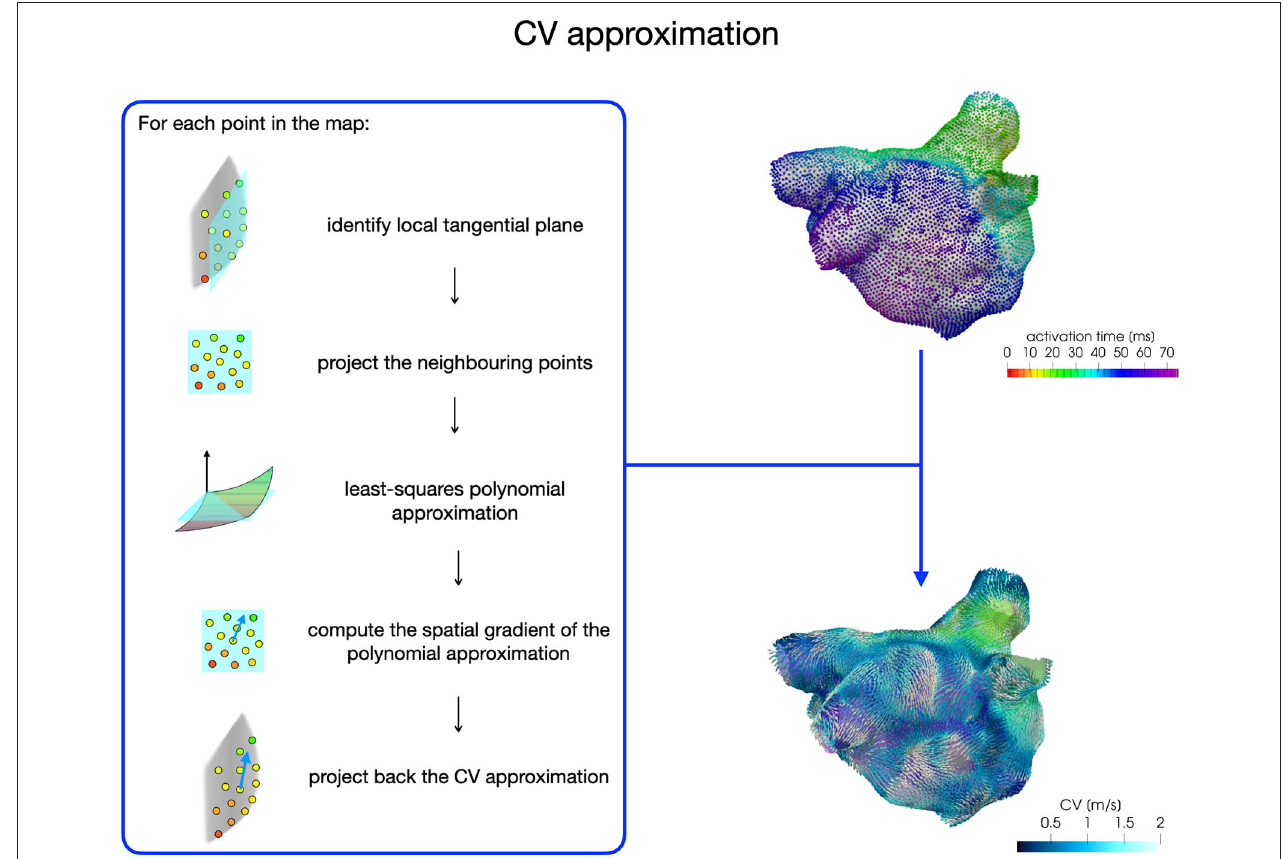
FIGURE 2 | CV vector approximation procedure based on a least-squares